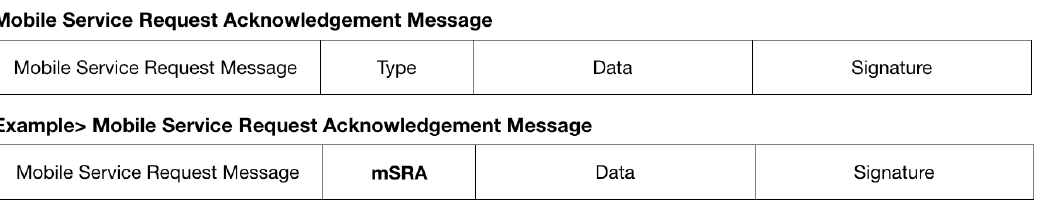
Figure 8. The mSR acknowledgement (mSRA) message format and